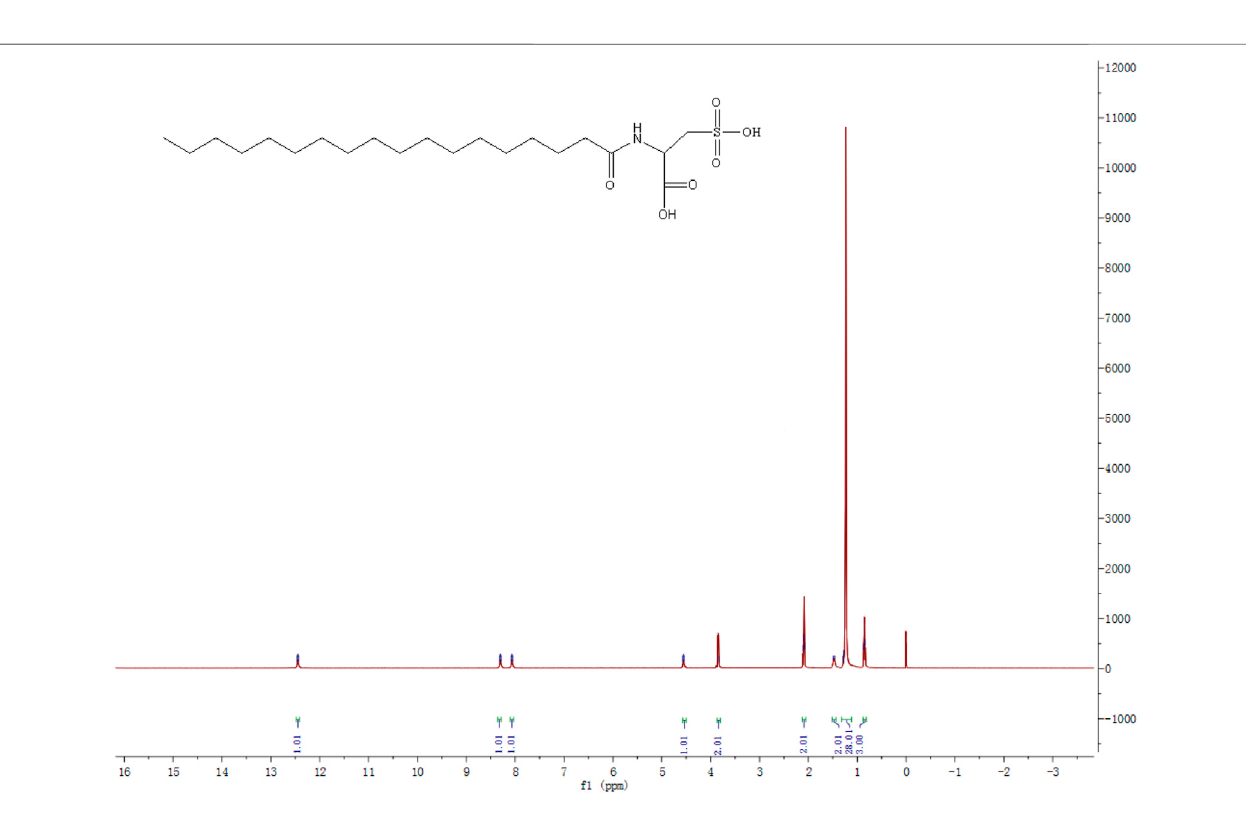
FIGURE 1 | 1H-NMR spectrum of